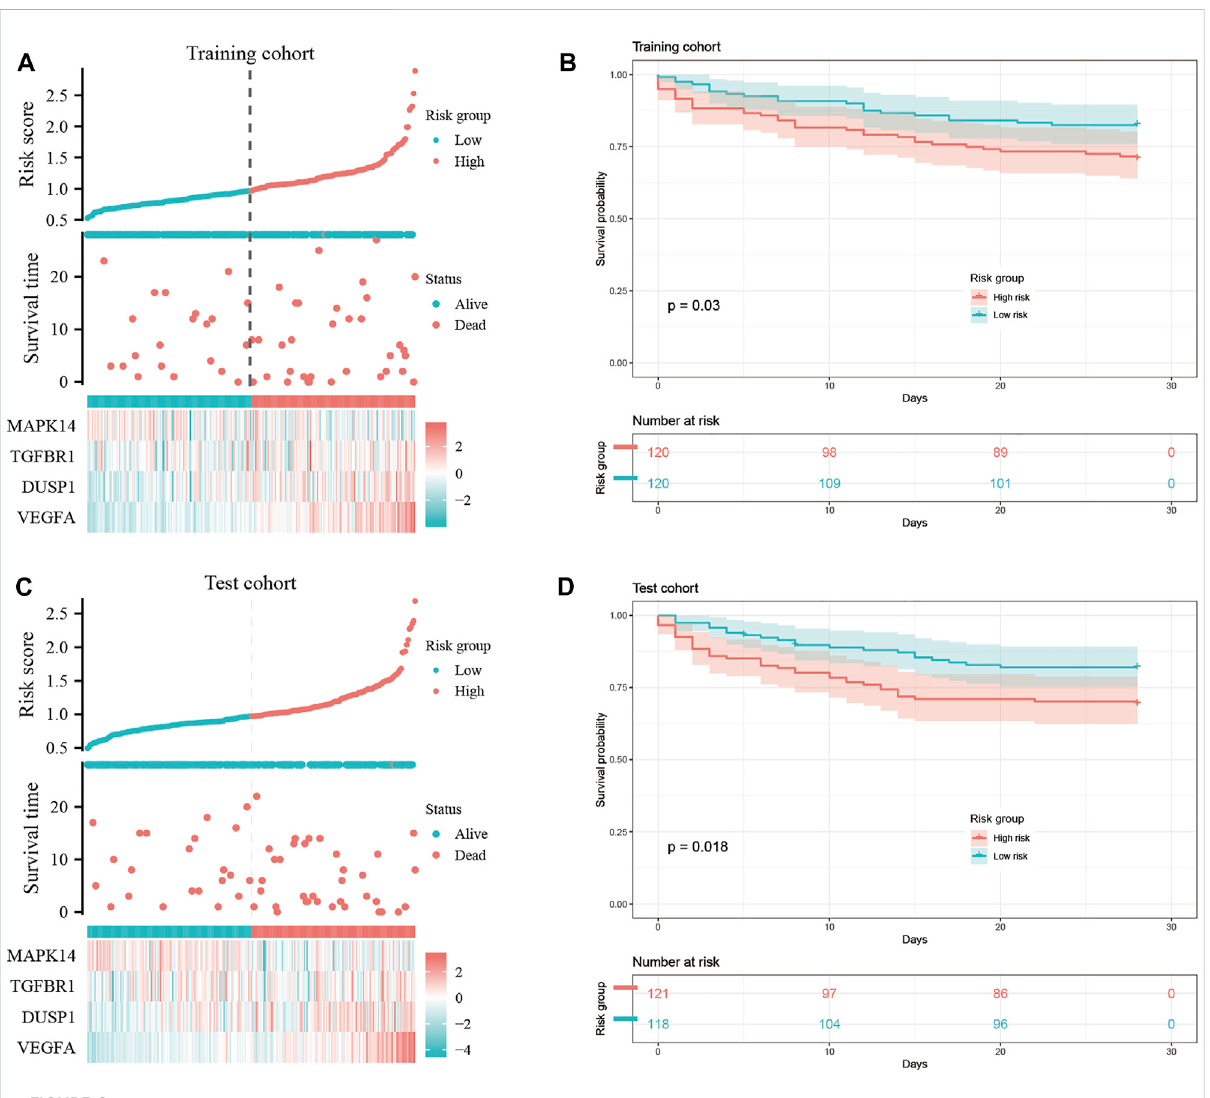
FIGURE 8 Construction of a “ prognostic signature ” and survival analyses. Risk scores (A,C) and survival outcome (B,D) of each case are